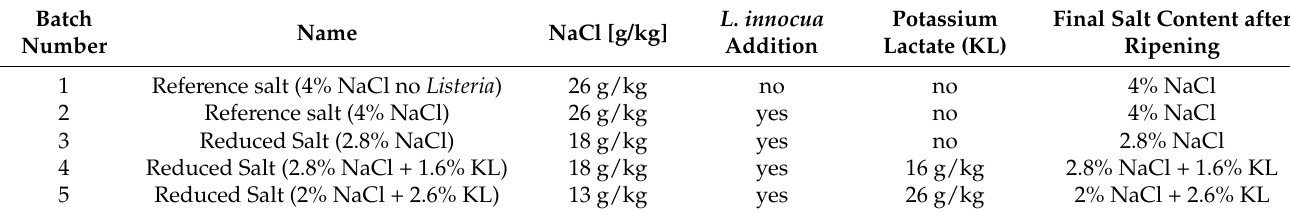
Table 2. Salami preparation and inoculation